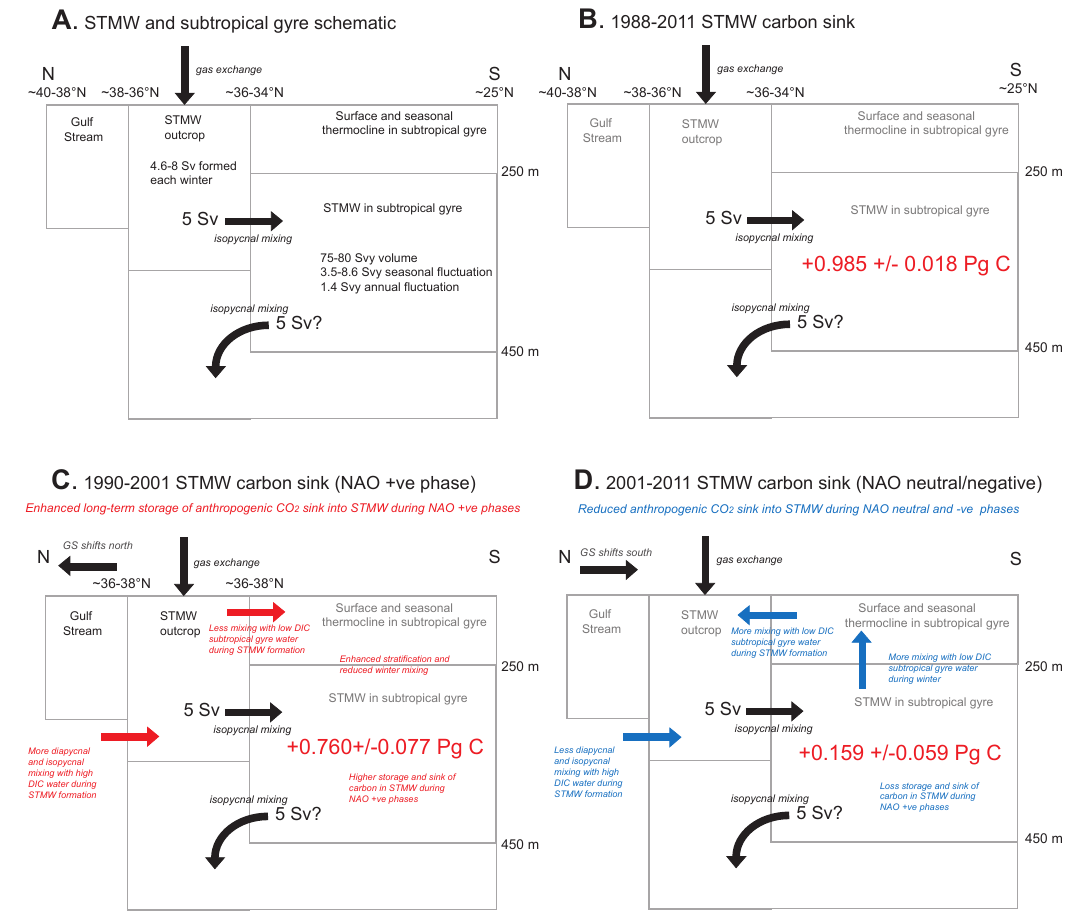
Fig. 4. Schematic of water masses and CO 2 sink estimates in STMW for different time-periods from 1988–2011. (A) Schematic of North Atlantic subtropical gyre showing Gulf Stream, STMW outcrop, surface and seasonal thermocline layer (not to scale). Range of winter STMW formation rates (Sv; Speer and Tziperman, 1992; Kwon and Riser, 2004; Forget et al., 2011), volume of STMW (Svy; Maze et al., 2009; Forget et al., 2011), and seasonal/annual fluctuations in the volume of STMW (Kwon and Riser, 2004; Forget et al., 2011) are given. (B) Estimate of CO 2 sink into STMW (PgC) for 1988–2011 period. (C) Estimate of CO 2 sink into STMW (PgC) for 1988–2001 period. (D) Estimate of CO 2 sink into STMW (PgC) for 2001–2011